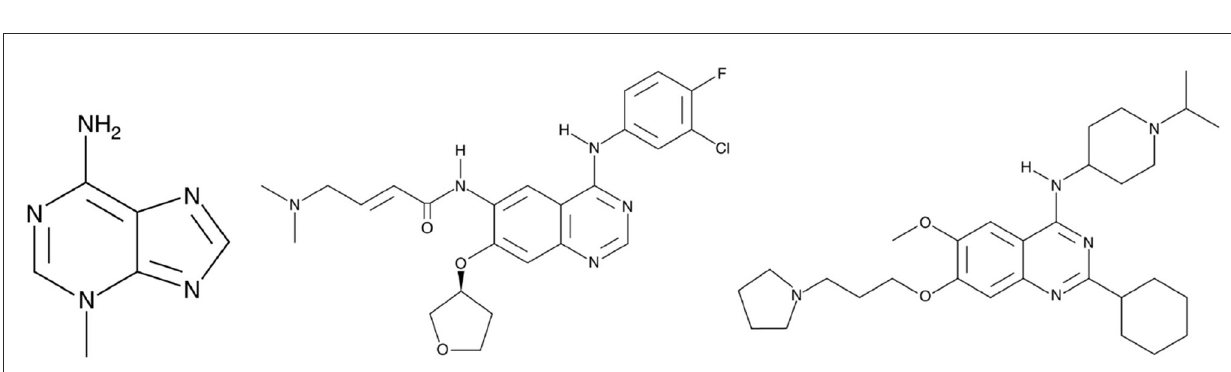
while the other four properties have lower values than